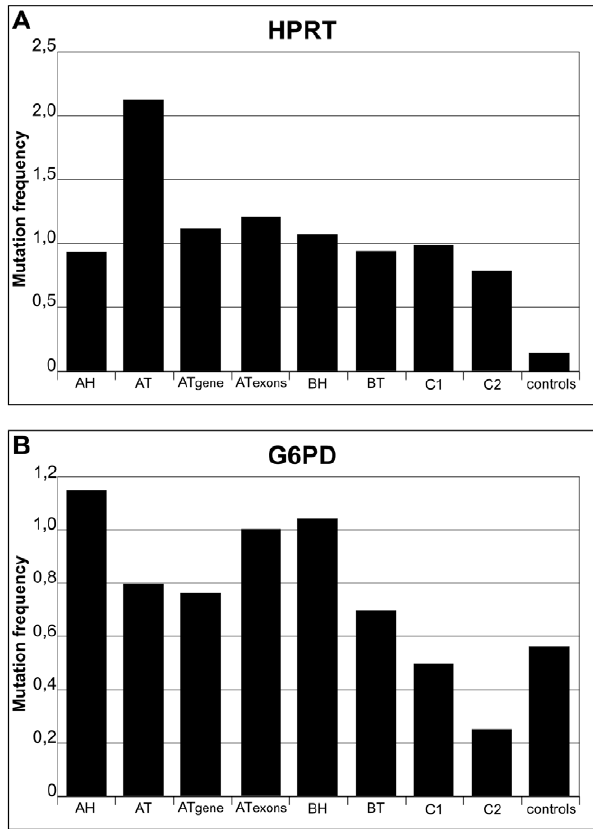
Figure 3. Mutation frequency values of all analyzed sequences of HPRT and G6PD cDNA and genes. Panel A, values of HPRT sequences; Panel B values of G6PD sequences. AH, AT, BH, BT: values calculated for cDNA clones of Tumour and nearby Healthy tissues of patients A and B. C1 and C2: values for cDNA clones from blood tissues of 2 healthy reference individuals. AT gene: values for clones of global genomic regions of DNA from tumour tissues of patient A. AT exons: values for the exon regions of the sequenced genomic regions. Controls: values for clone samples.